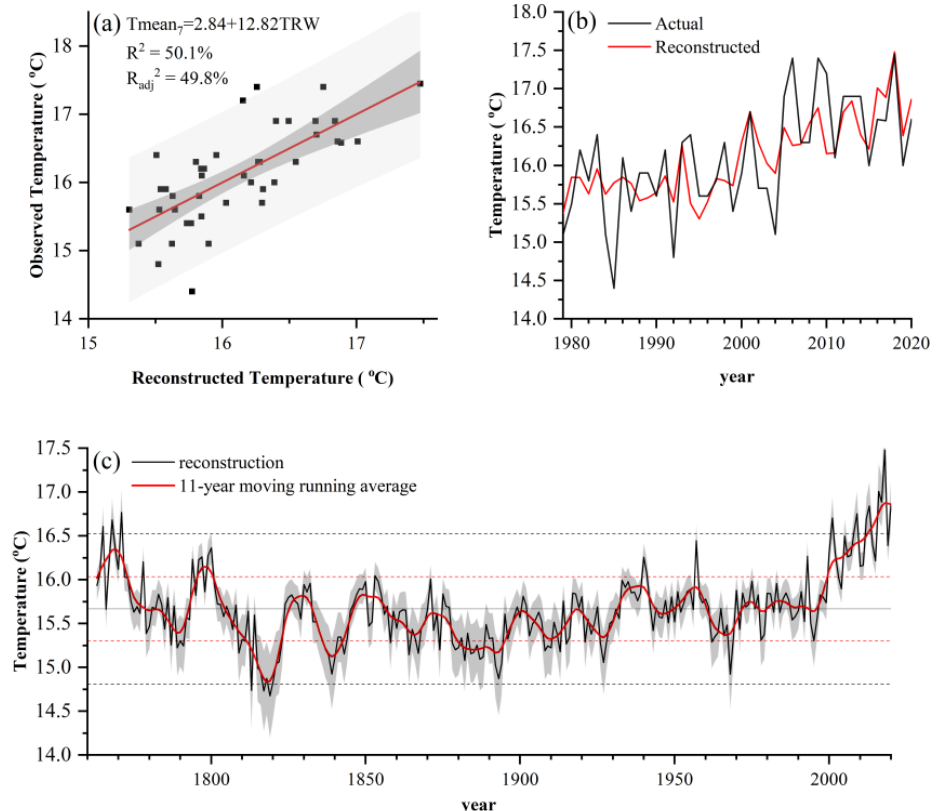
Figure 4. Scatter plot of the observed and estimated July mean temperature, regression line (red line) and equation ( a ); graph of the observed and estimated July mean temperature for the calibration period 1979–2020 ( b ); reconstructed July mean temperatures (thin black line) and 11-year moving running average smoothing filter (thick red line) both based on tree-ring width (TRW) data from 1763 to 2020, the gray area denotes the confidence interval at 95%, the red dashed lines denote the mean ± 1 σ , and the black dashed lines denote the mean ± 2 σ ( c ).